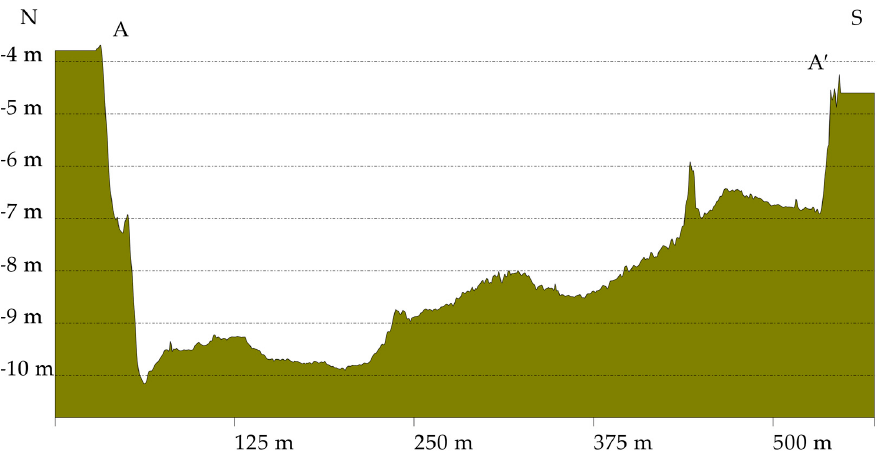
Figure 7. Bathymetric profile A-A’ in the inlet area (location of bathymetric profile in Figure 3).